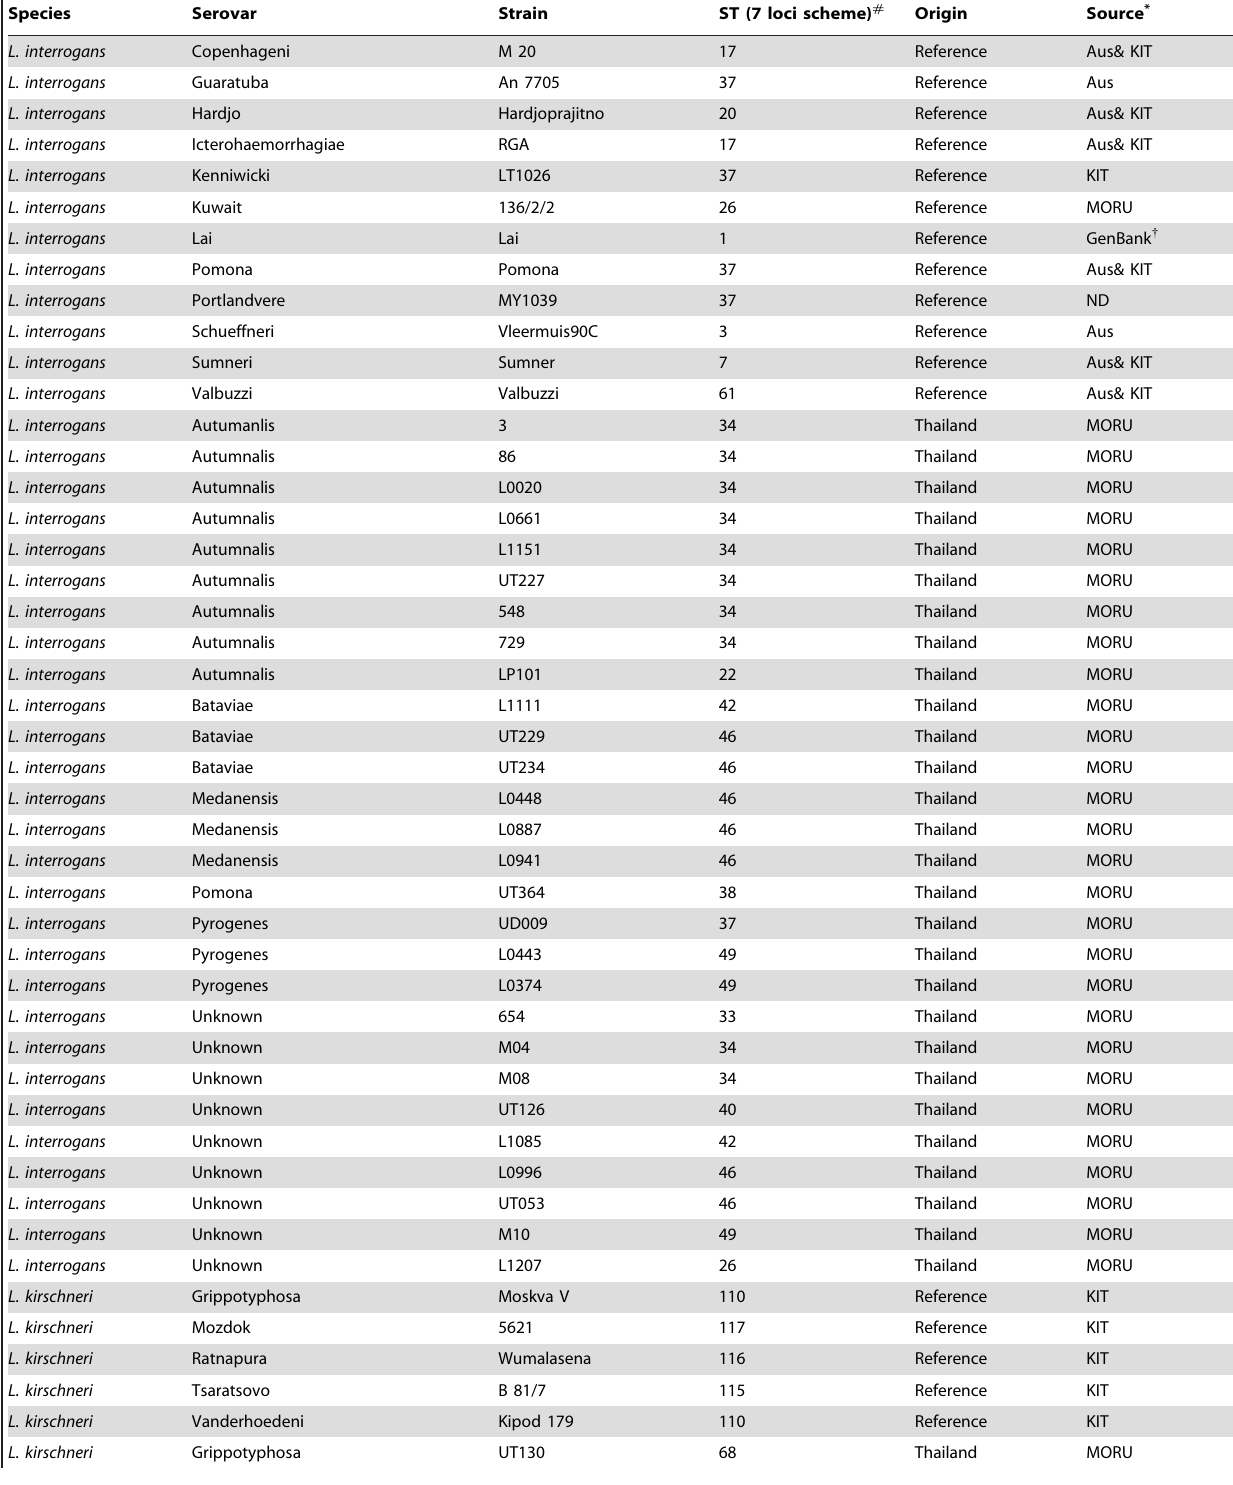
Table 1. Leptospira isolates used in this study.